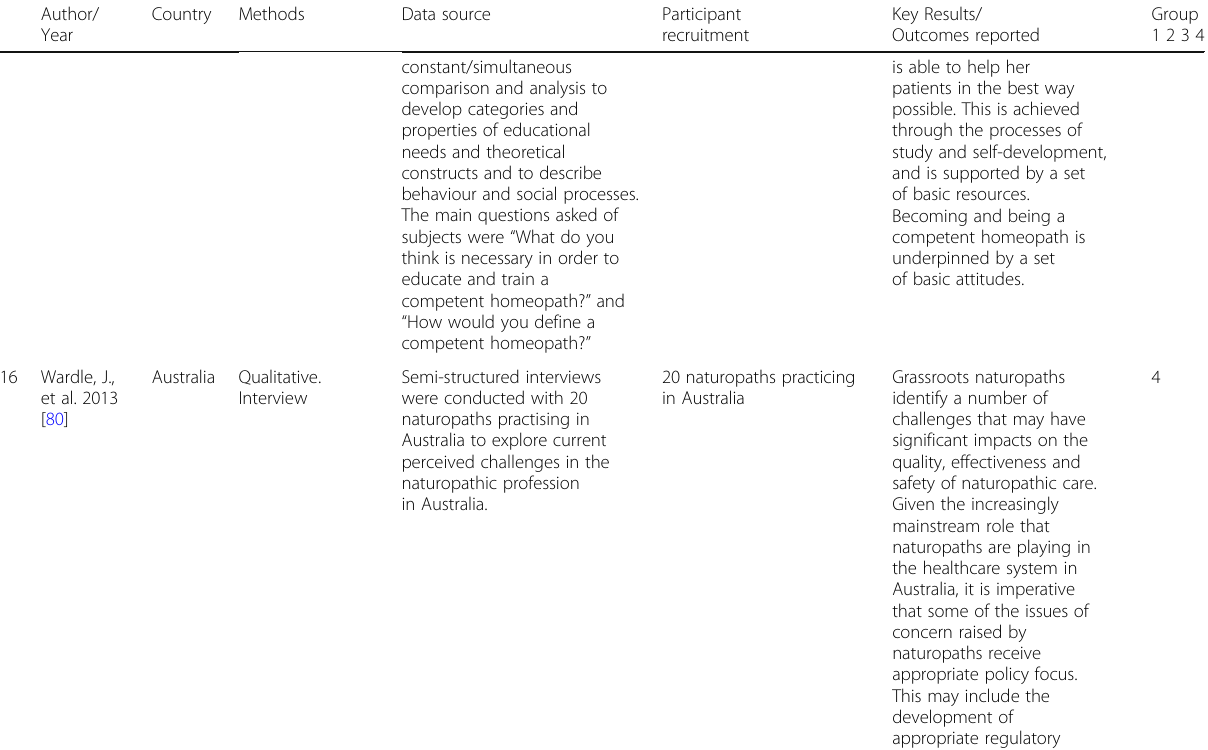
Table 2 Study Characteristics of Included Studies and Thematic Categories (1 CM education provision, 2 The development of educational competencies to develop clinical skills and standards, 3 Application of new educational theory, methods and technology in CM, 3 Future Challenges facing CM education)